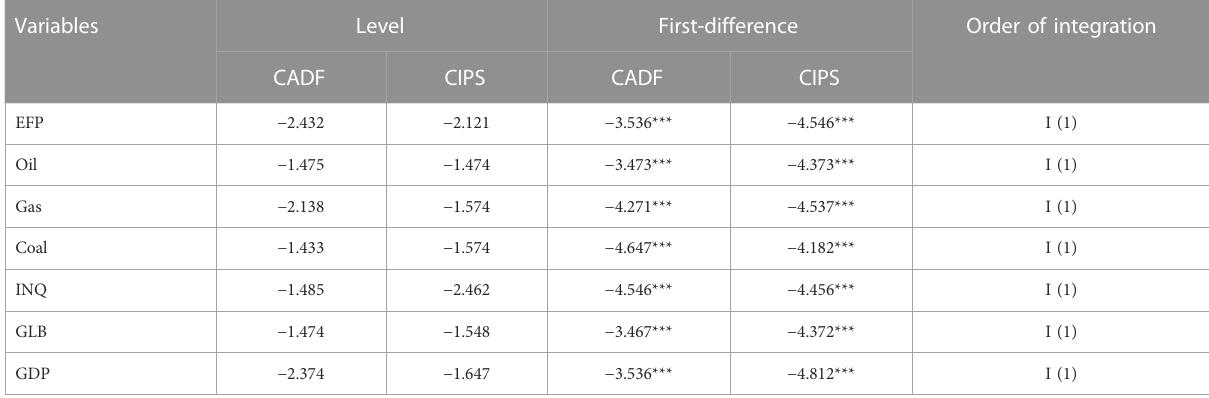
TABLE 2 Stationarity